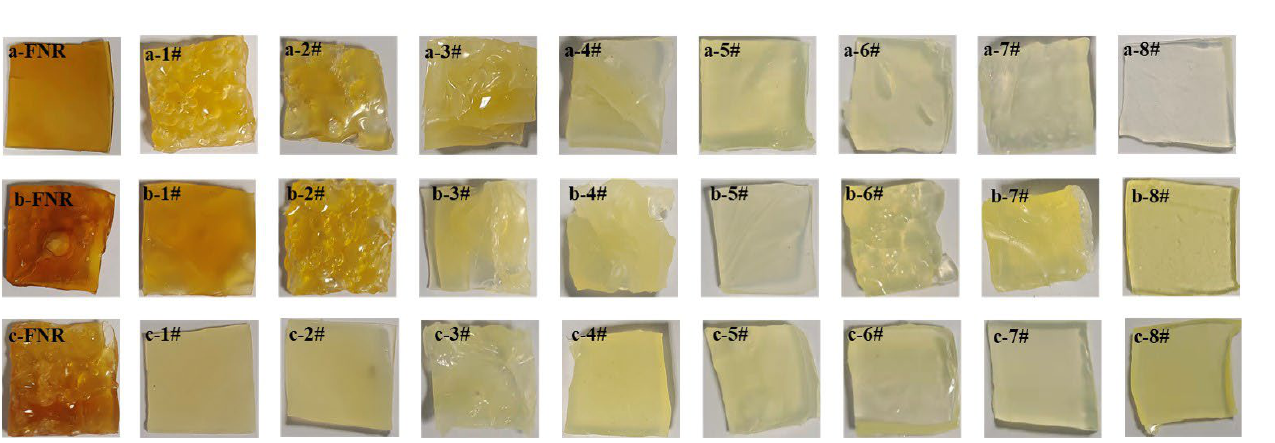
Figure 2. Photos of rubber films obtained from latexes with rubber particles of various sizes (( a ) IAN873; ( b ) Dongfang93114; ( c ) Reyan73397; 1# to 8#: Rubber films obtained from latex-#1 to latex-#8).